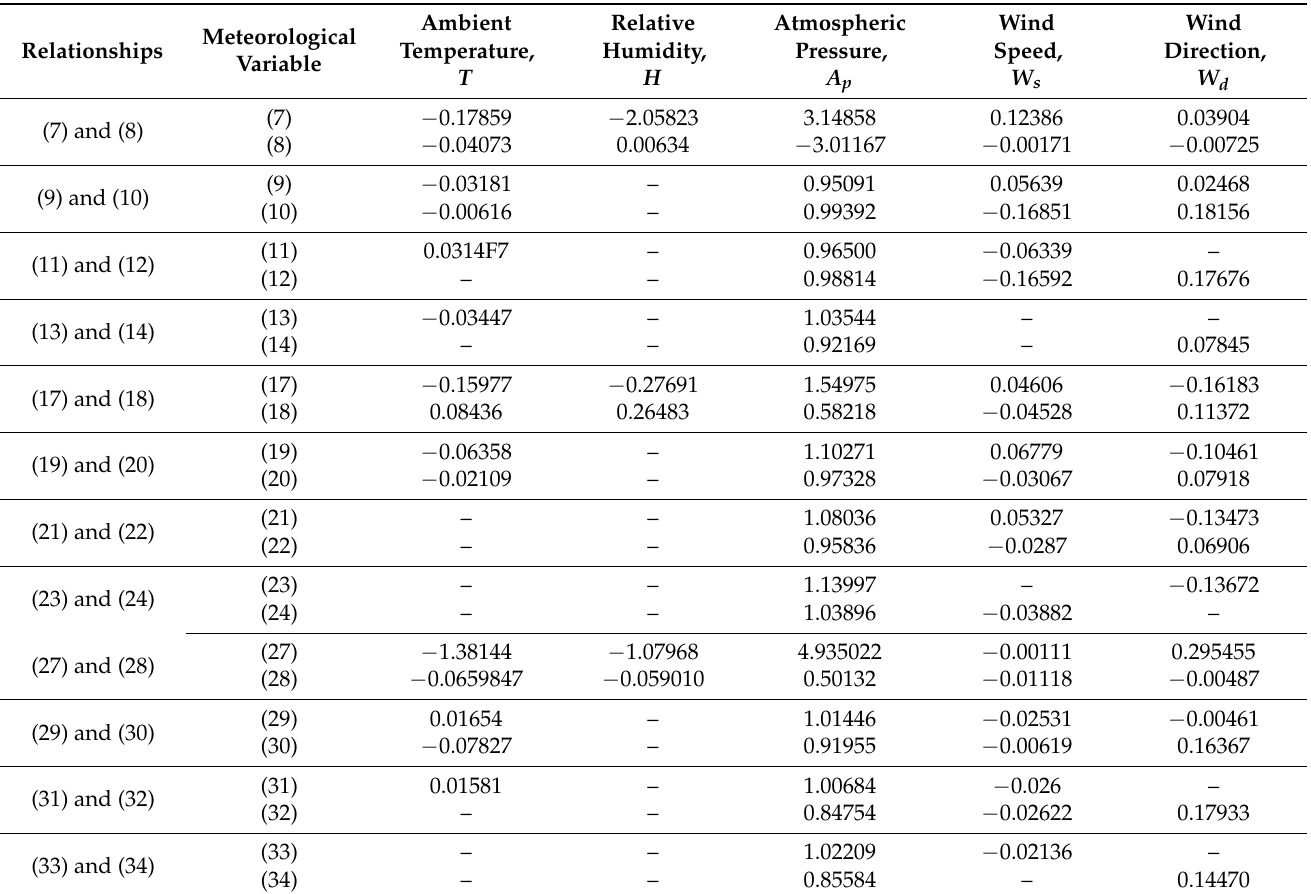
Table 2. Partial flexibility coefficients of the meteorological variables included in linear relationships (7)–(14), (17)–(24), and